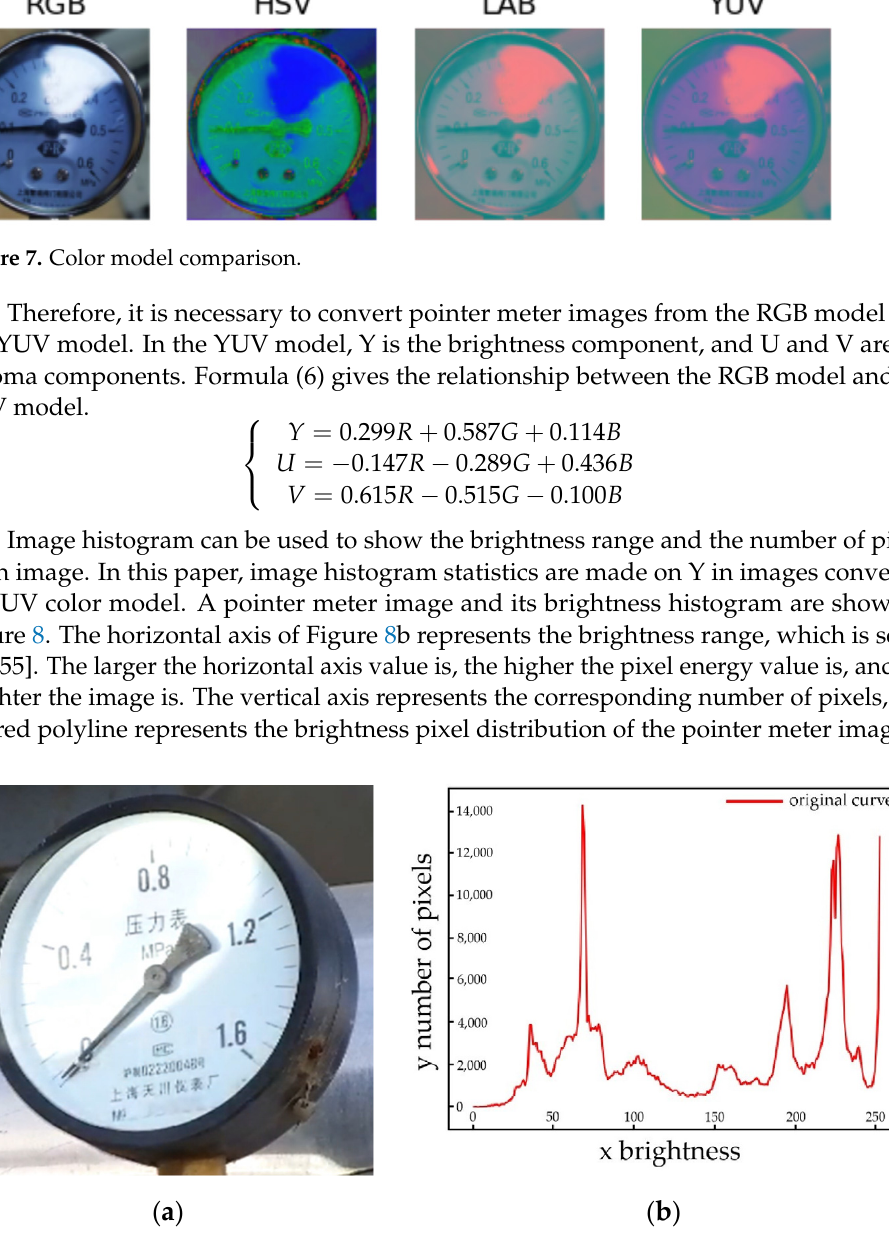
Figure 8. Brightness component histogram; ( a ) original figure; ( b ) histogram.